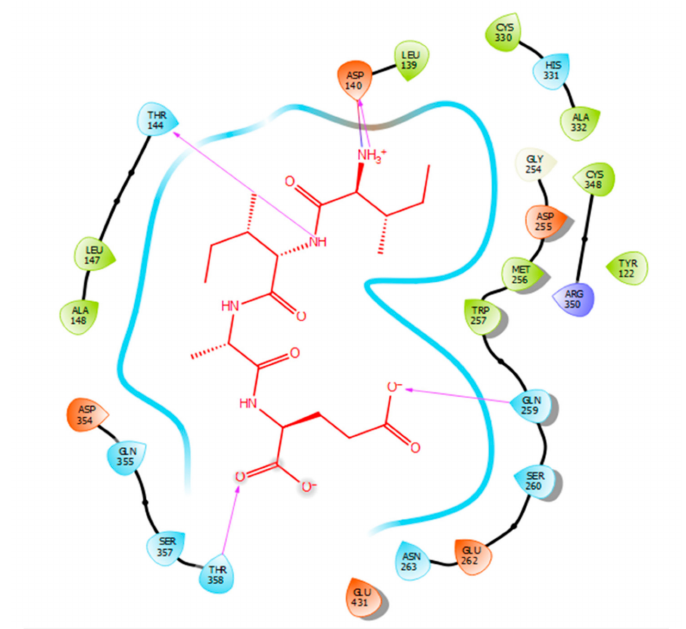
Figure 3. Docking results of the peptide IIAE in the active site human ACE. IIAE is represented in red, the interactions of human ACE residues with the peptide are indicated by arrows of di ff erent colours with purple representing hydrogen bond interactions, and blue arrows representing salt bridge interactions. The Figure was obtained using the software Maestro.